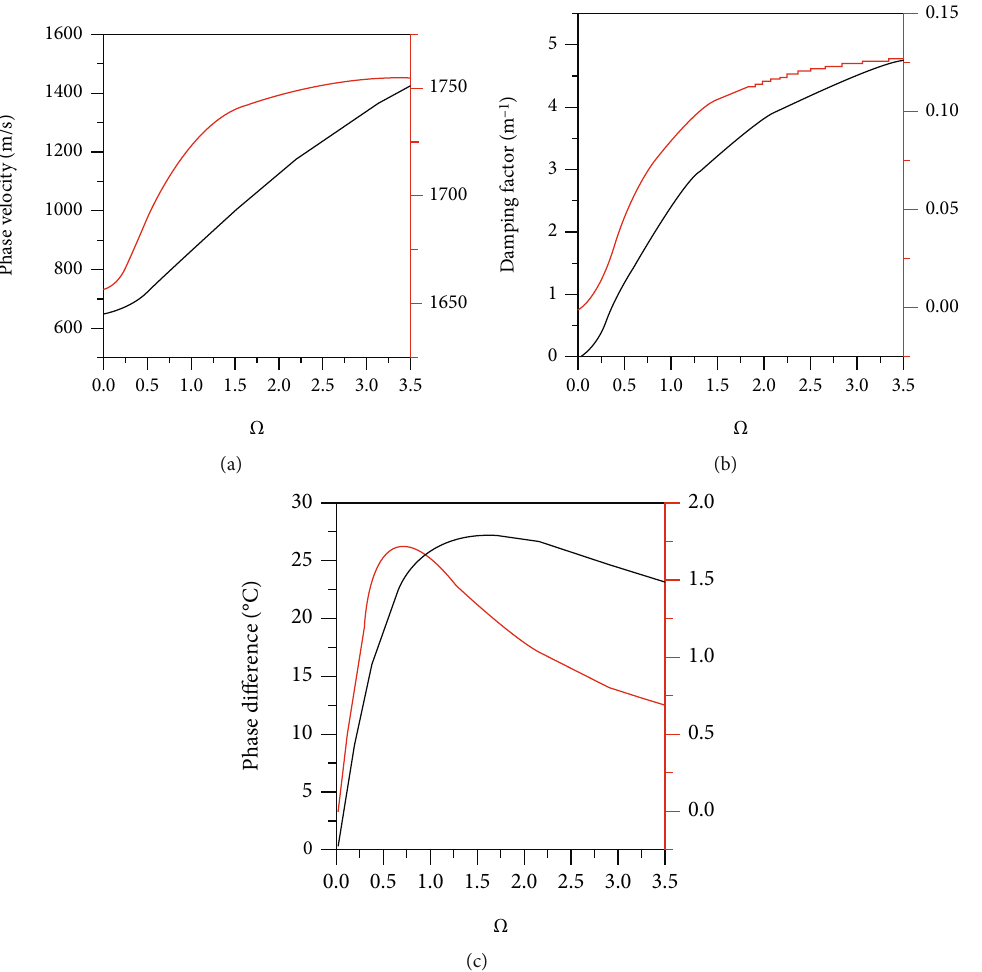
Figure 4: Phase velocity (a), damping factor (b), and phase di ff erence (c) of the wave versus normalized frequency ( Ω = ω / ω λ λ λ λ = λ . The red line presents the Darcy-Brinkman law and the black line Darcy ’ s condition of λ 1 4 7 2 5 6